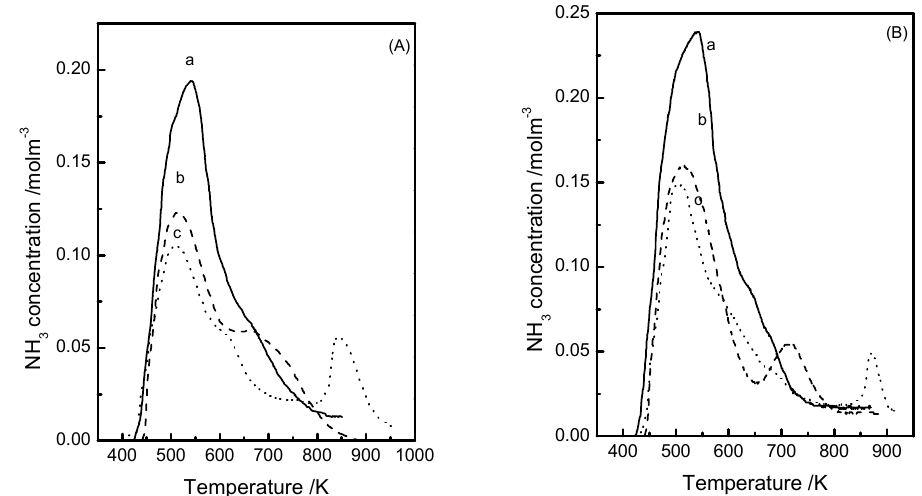
Figure 3. NH 3 -TPD spectra of ( A ) H-zeolite a. H-Y, b. H-Beta, c. H-ZZs-0.3; ( B ) MnH-zeolite a. MnH-Y, b. MnH-Beta, c. MnH-ZZs-0.3.